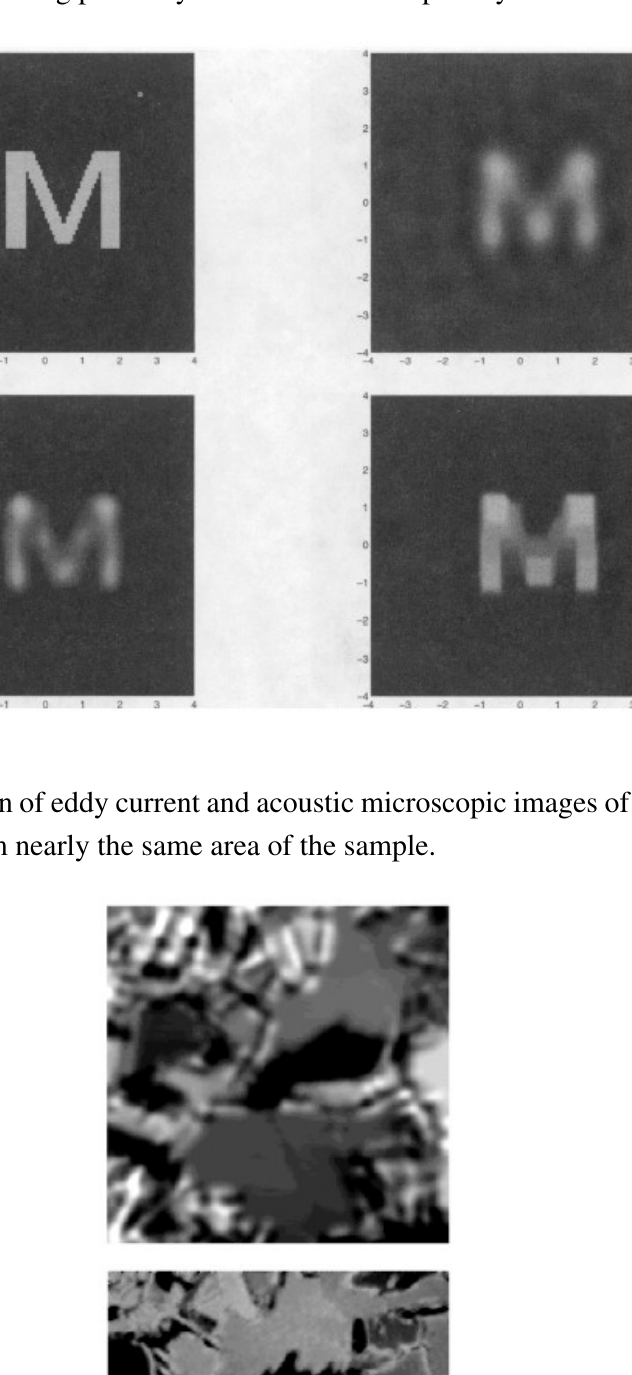
Figure 13. Numerical reconstructions from noisy synthetic data. On the top left is the true loss profile; on the top right is the profile obtained using least squares; and on the bottom row are the effects of adding positivity and total variation penalty.